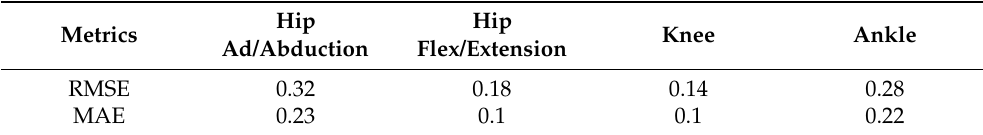
Figure 10. Desired trajectory and the adjusted trajectory based on the simulated lower limb exoskeleton. Table 4. Metrics between desired trajectory and the adjusted